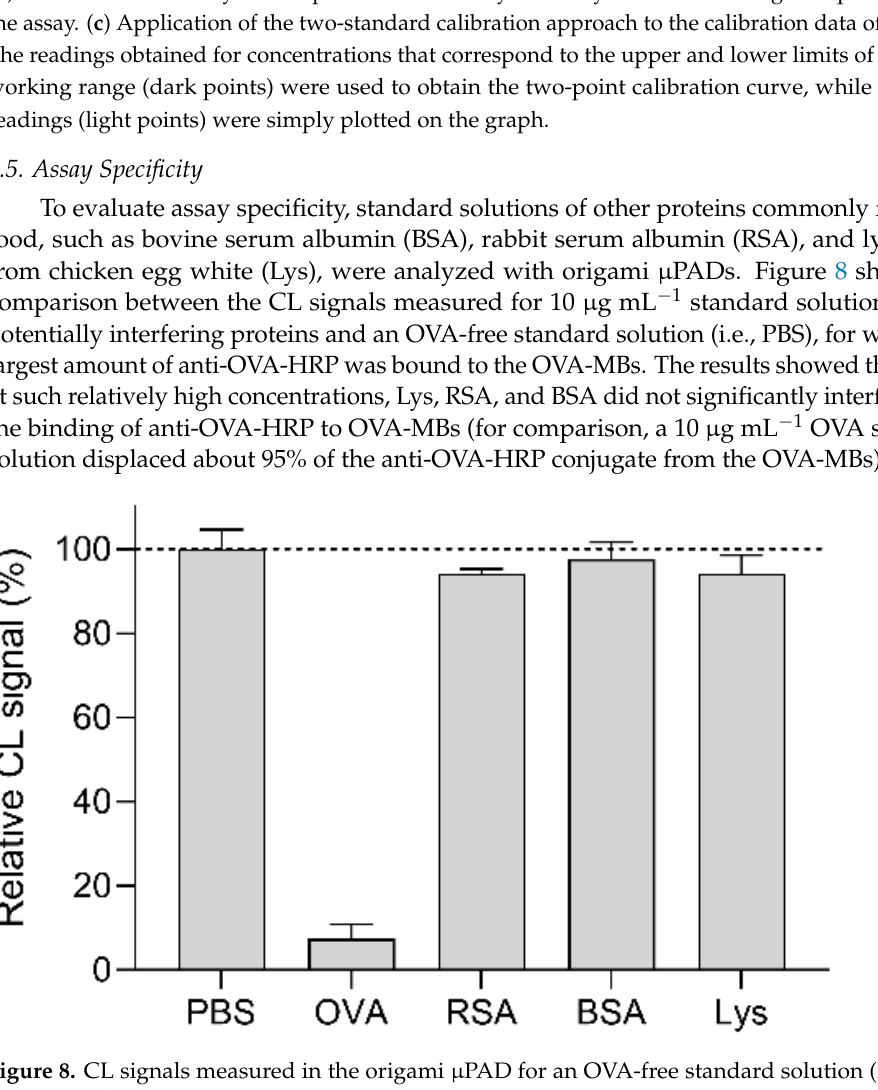
Figure 8. CL signals measured in the origami µ PAD for an OVA-free standard solution (PBS) and 10 µ g mL − 1 standard solutions of the potentially interfering proteins RSA, BSA, and Lys. For comparison, the CL signal measured for a 10 µ g mL − 1 OVA standard solution is reported. Each of the data are the mean ± SD of three measurements.